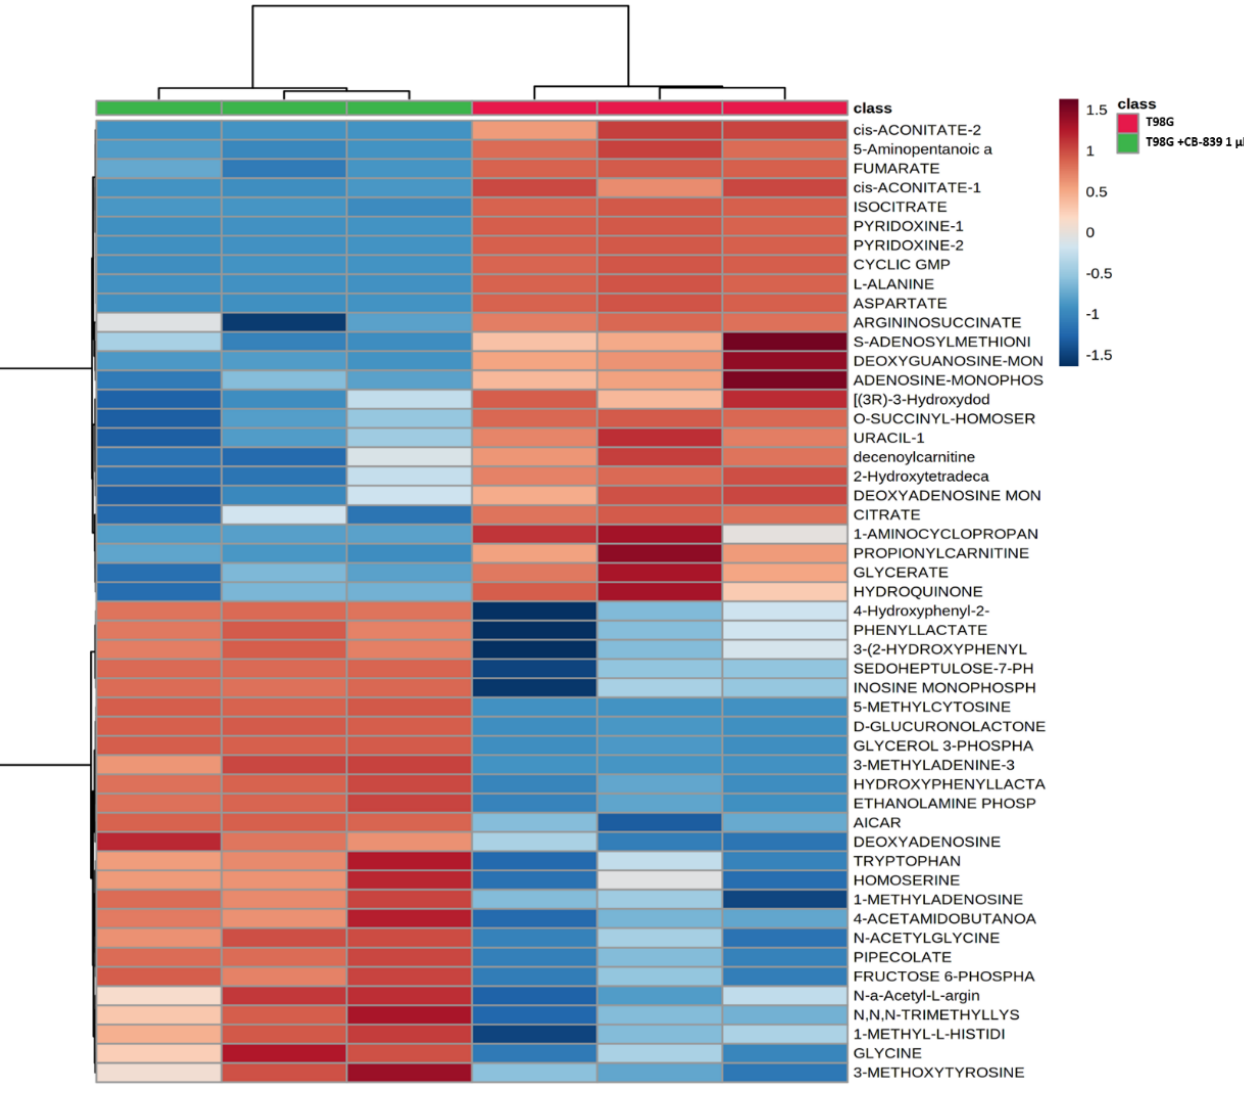
Figure 4. Metabolomic changes elicited by CB-839 are depicted on a representative hierarchical clustering analysis of key molecules in the T98G glioma cell line. The heat map shows the top 50 differentially altered metabolites in GBM cells were exposed for 24 h to 1 µ M CB-839. The samples were run in triplicate. For more details, see Section 2.